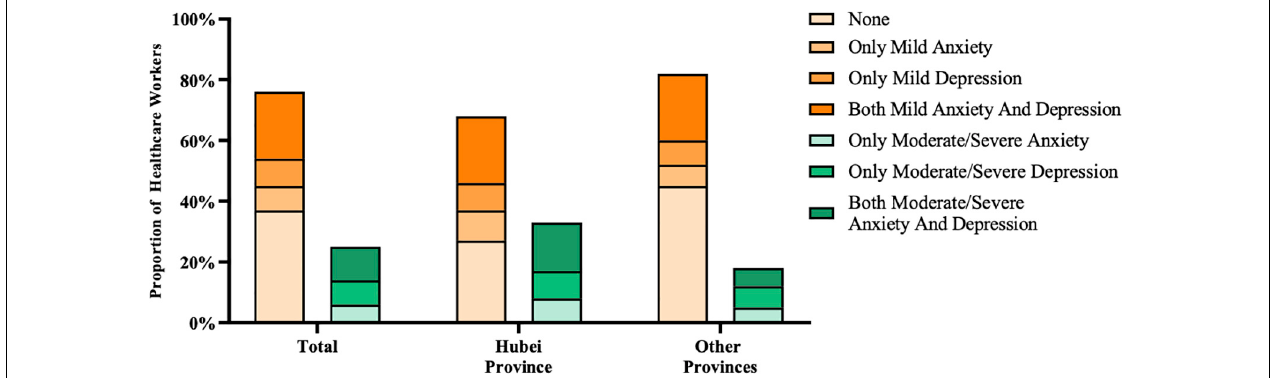
FIGURE 1 | Distribution of ADSs in Hubei province and other provinces. The occurrence of ADSs can be single or coexistent, although most participants in our study had both ADSs. Healthcare workers in Hubei province had a higher prevalence of moderate or severe ADS than those of other provinces. TABLE 2 | Multiple logistic regression analysis with risk factors for moderate/severe ADSs ( n = 928) (C statistic = 0.752). Variables p -value OR (95%